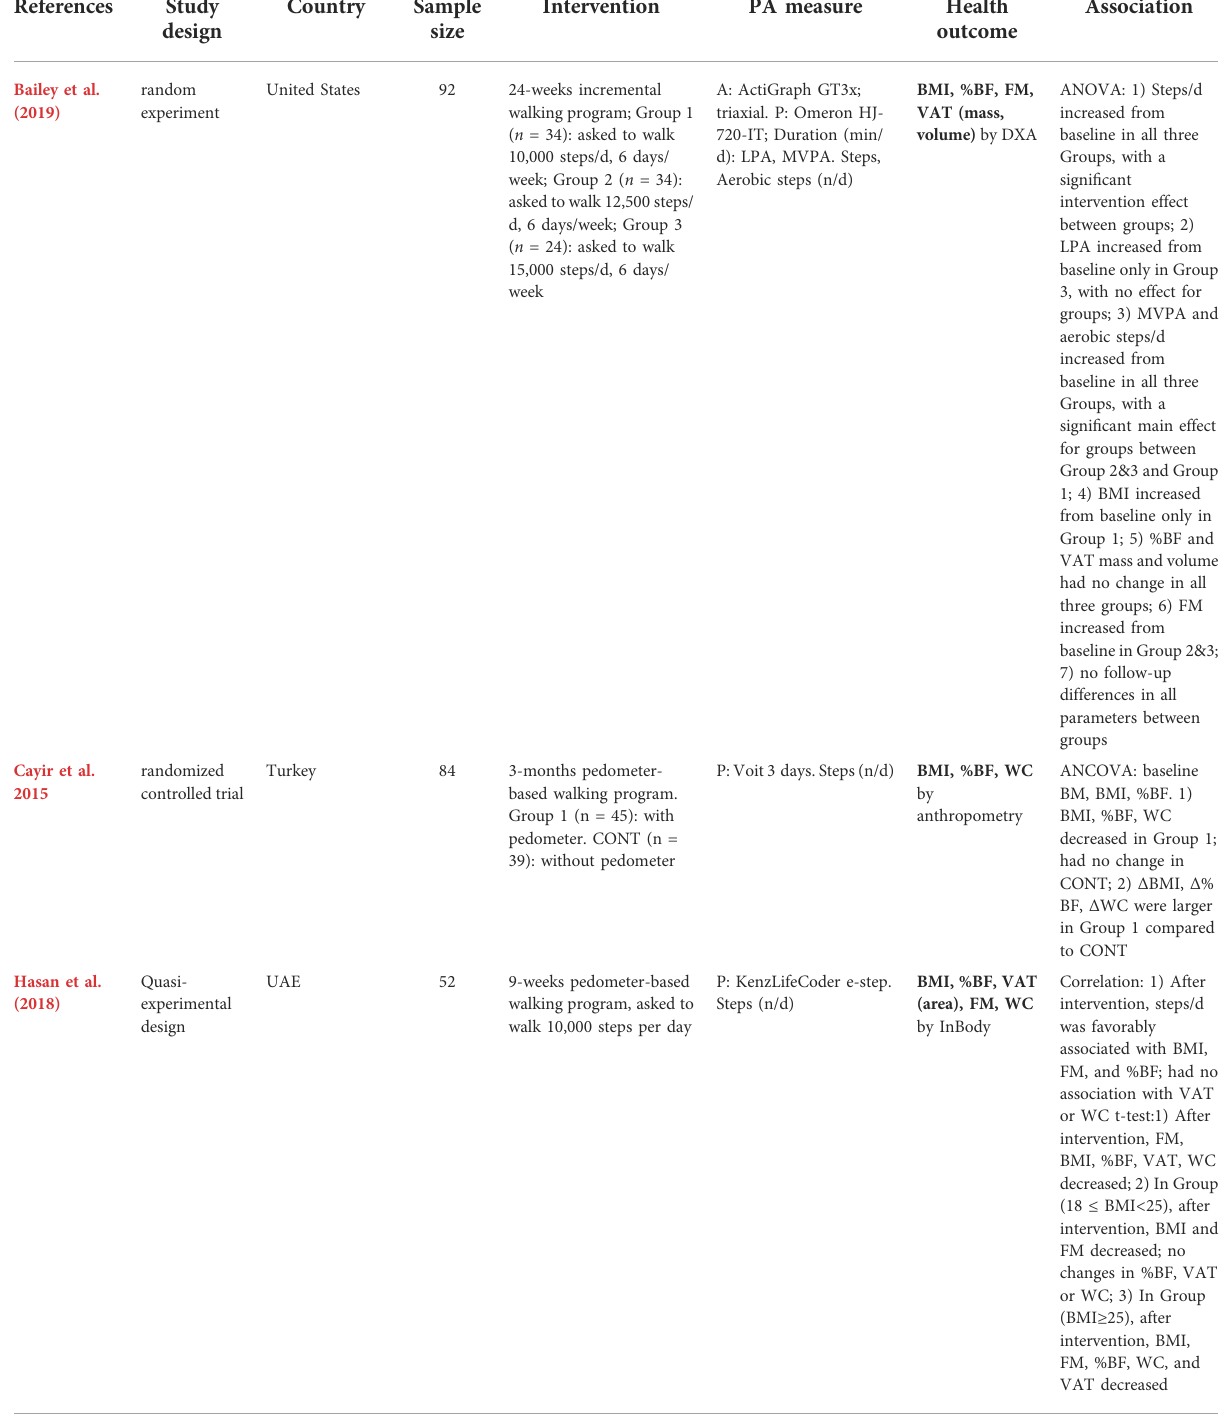
TABLE 2 Characteristics of intervention